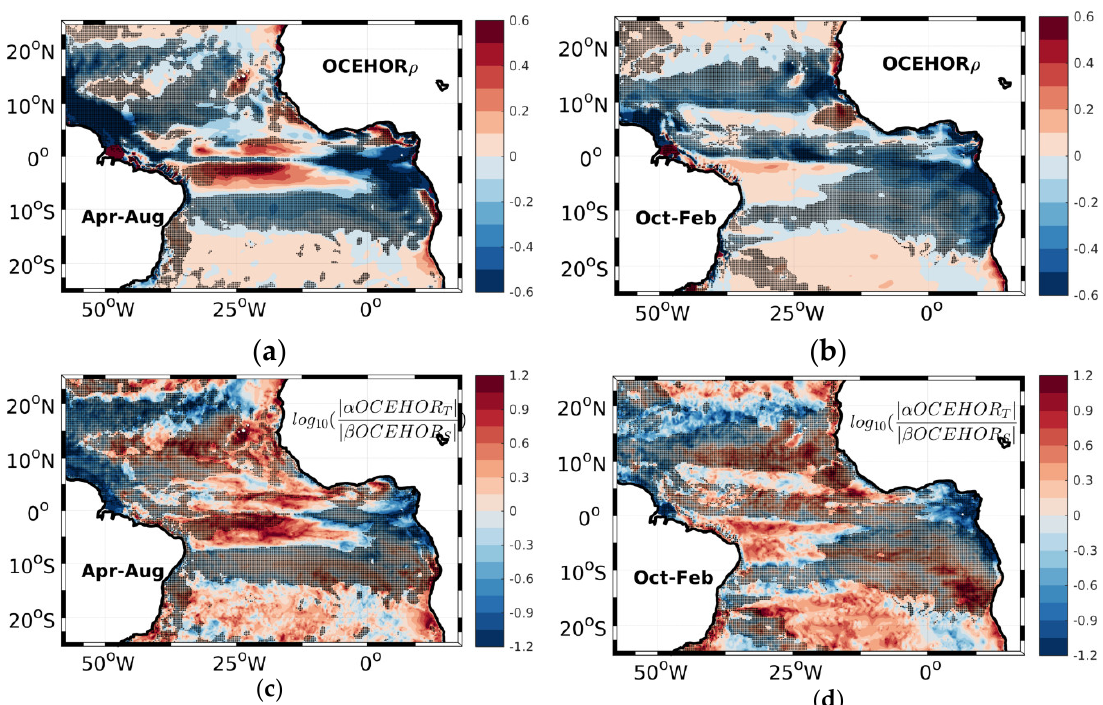
Figure 5. April-August ( a ) and October-February ( b ) average of the contribution of total horizontal oceanic physical processes to mixed layer density variations. Units are in kg.m −3 month −1 . ( c , d ) are the logarithm of the ratio between the absolute value of the total heat and salt horizontal oceanic physical processes contribution. On all panels, regions where heat and salt horizontal physical processes contribution on mixed layer density is the same in terms of signs indicated with black dots.